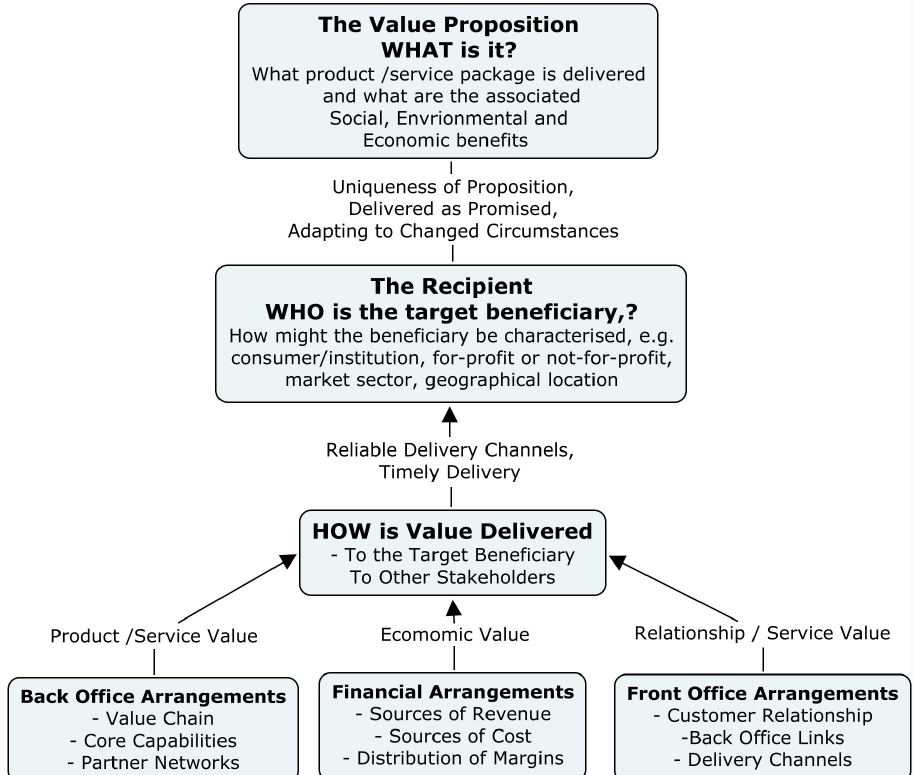
Fig. 1. Business Model Analysis